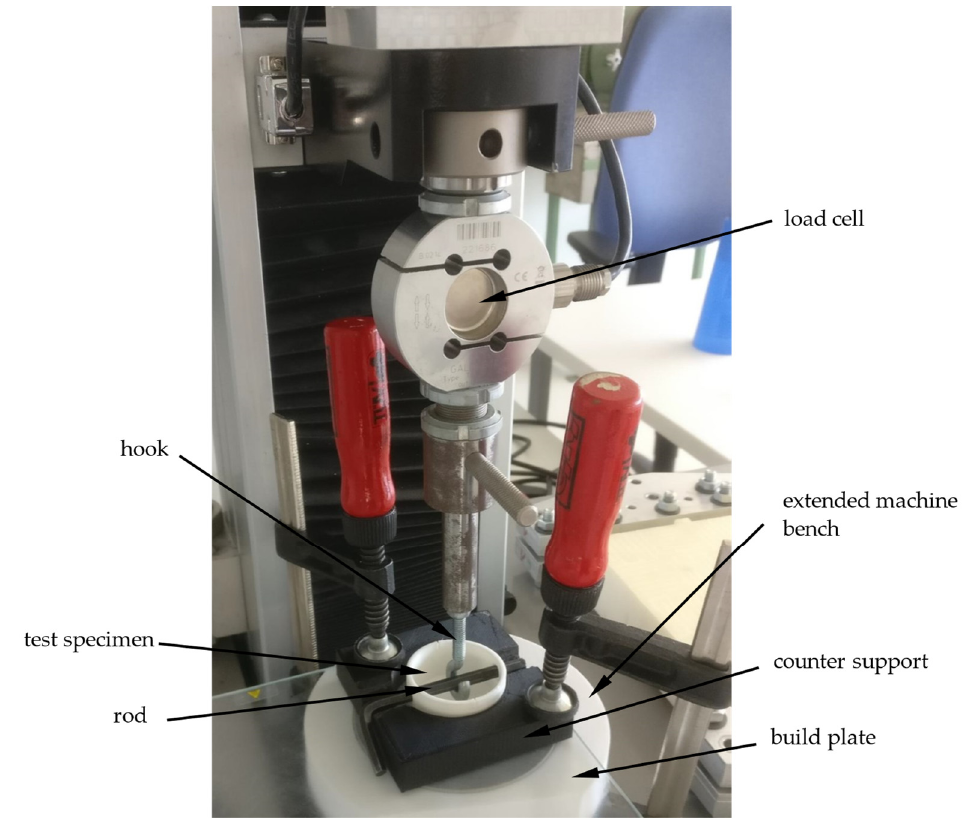
Figure 3. Setup for the tensile test [7].